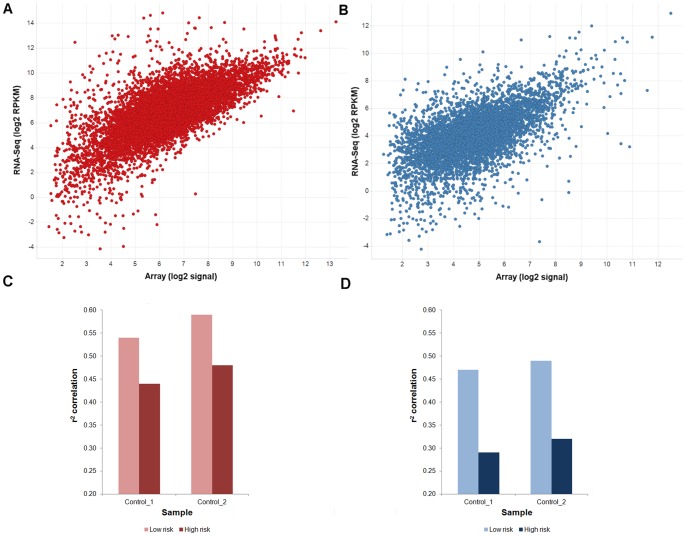
RNA-Seq versus microarray gene expression correspondence.Comparison between RNA-Seq and microarray platforms across 8621 human and 5467 mouse genes from a Calu-6 human xenograft sample (Control_2) and detected on both platforms. Correlation in gene expression in (A) human (r2 = 0.50) and (B) mouse (r2 = 0.35). r
2 values are calculated only from genes detected on both platforms. The transcript mapped by the highest number of reads was chosen to represent the expression of its parent gene. Any gene containing at least one mappable read was classed as detected in RNA-Seq. A gene was called “present” on the array if the signals of all probesets assigned unambiguously to that gene were separable from the general background with a p-value<0.01. Correlation increases between (C) human and (D) mouse gene expression values across both samples when probes on the array at high risk of cross-species hybridization are removed. Only genes detected on both platforms were considered. A mean of ∼8400 human and ∼5300 mouse genes were used in the comparison of which ∼6800 and ∼4400 genes were deemed at high risk respectively. Genes at high risk were defined as those corresponding to a probe with up to three mismatches to the transcriptome of the alternative species.